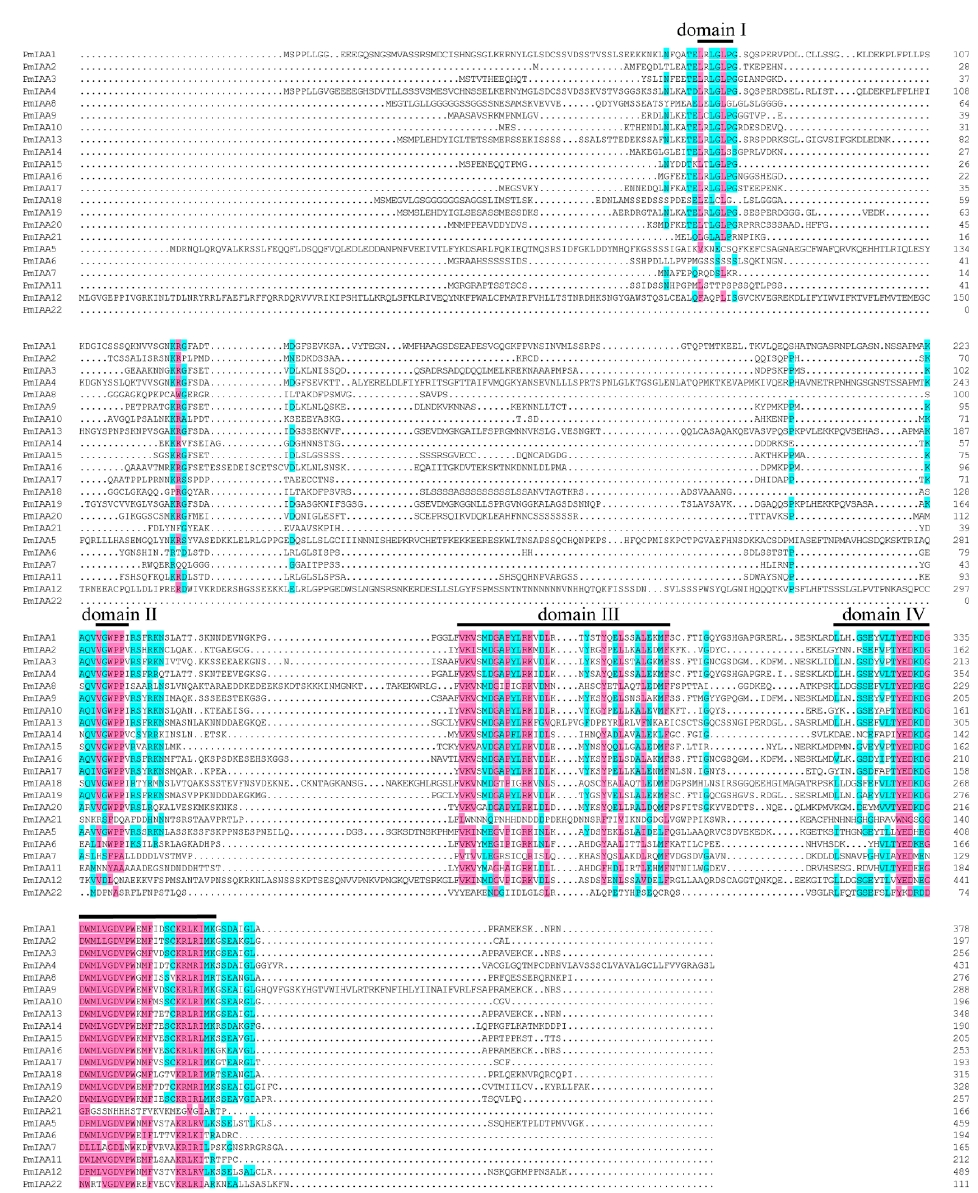
Figure 6. Multiple sequence alignment of PmIAAs. Conserved domains I–IV are marked by thick black lines. More than 75% similarity of amino acids are shaded in red, and ranged from 50% to 75% amino acids are shaded in blue. Location information of domains is inferred by right numbers.